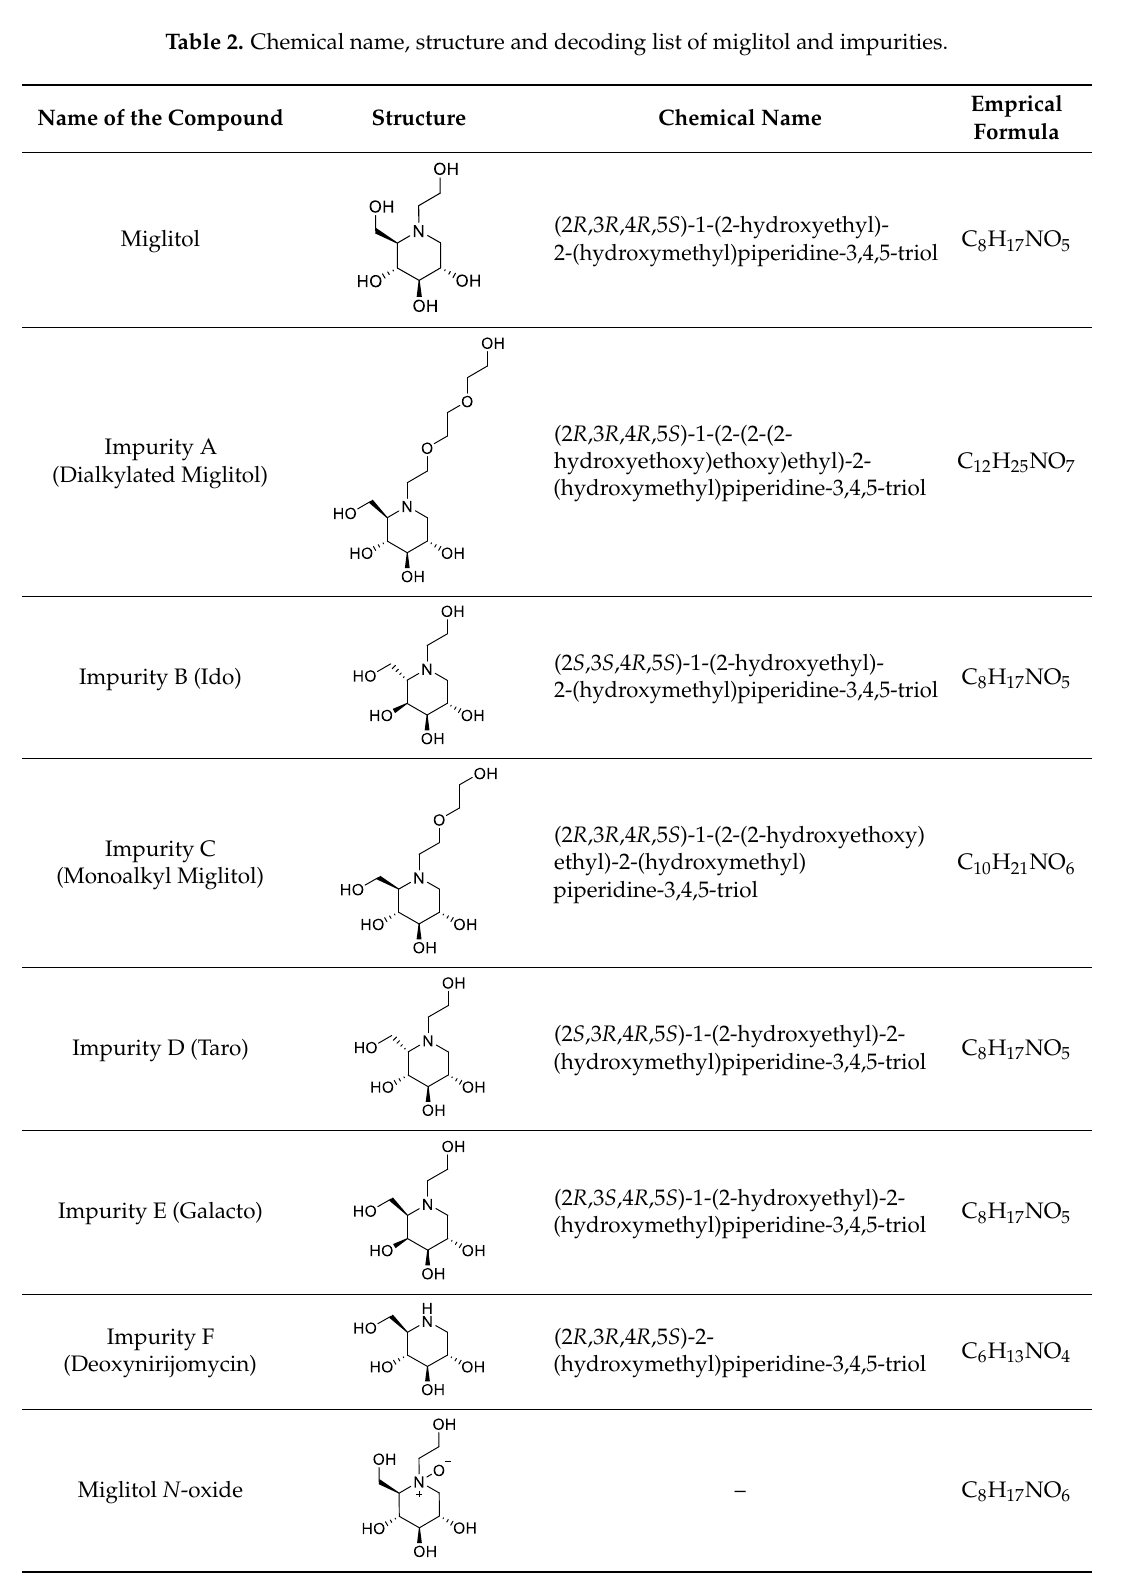
Table 2. Chemical name, structure and decoding list of miglitol and impurities. W.r.t: with respect to RSD: relative standard deviation.